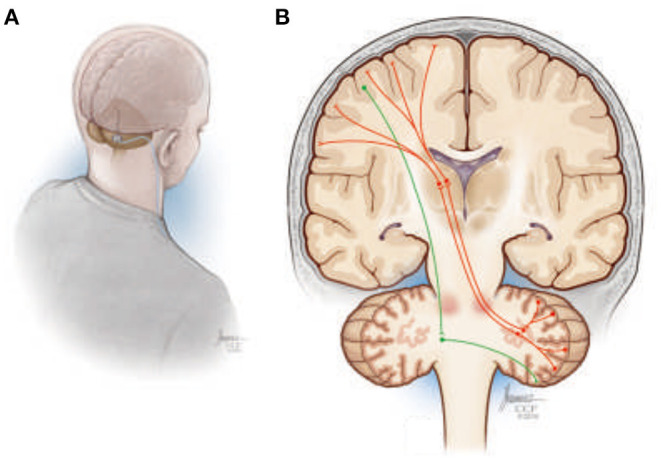
(A) Illustration depicting a suboccipital approach to delivering deep brain stimulation therapy to the cerebellar dentate nucleus. (B) Simplified overview of the human dentatothalamocortical (DTC) and corticopontocerebellar (CPC) pathways. The DTC (red) projects through the ipsilateral superior cerebellar peduncle, decussating at the level of the pons, to terminate in contralateral thalamus, where its activity influences widespread thalamocortical interactions. The CPC is shown in green descending from the cortex, decussating in the ipsilateral pons, and terminating in the contralateral cerebellar hemisphere.